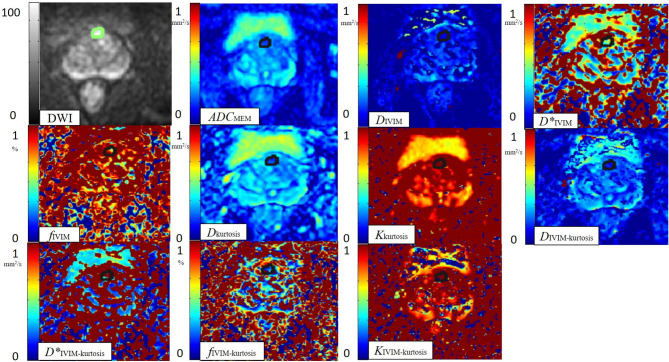
One case with BPH. A 60-year-old man with BPH. ROI was set in BPH on the DWI image. ADCMEM, DIVIM, D*IVIM, fIVIM, Dkurtosis, Kkurtosis, DIVIM−kurtosis, D*IVIM−kurtosis, fIVIM−kurtosis, and KIVIM−kurtosis value maps. The BPH tissue showed different signals notably from normal tissues on the DWI value map. The BPH tissue showed a slightly low signal on the ADCMEM (0.87 × 10−3 mm2/s), DVIM (0.45 × 10−3 mm2/s), Dkurtosis (1.34 × 10−3 mm2/s), and DIVIM−kurtosis (1.22 × 10−3 mm2/s) value maps. The BPH tissue seemed to be similar to normal tissues on the D*IVIM (4.09 × 10−3 mm2/s), fIVIM (46.17%), Kkurtosis (0.96), D*IVIM−kurtosis (1.65 mm2/s), fIVIM−kurtosis (15.25%), and KIVIM−kurtosis (1.01) value maps.